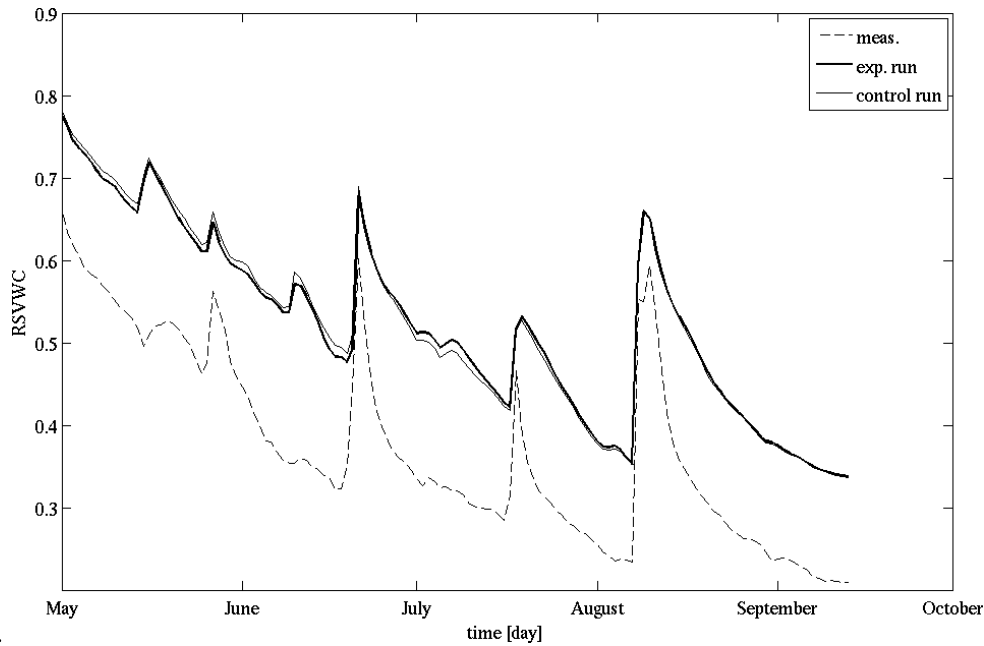
Figure 12. Mean daily values of soil relative humidity ( i.e. , the volumetric soil water content normalized by the soil porosity) at 10 cm below the surface, during the 2009 vegetative season. The dashed line shows the measurements while the thick line refers to the experimental run and the thin line to the control run.